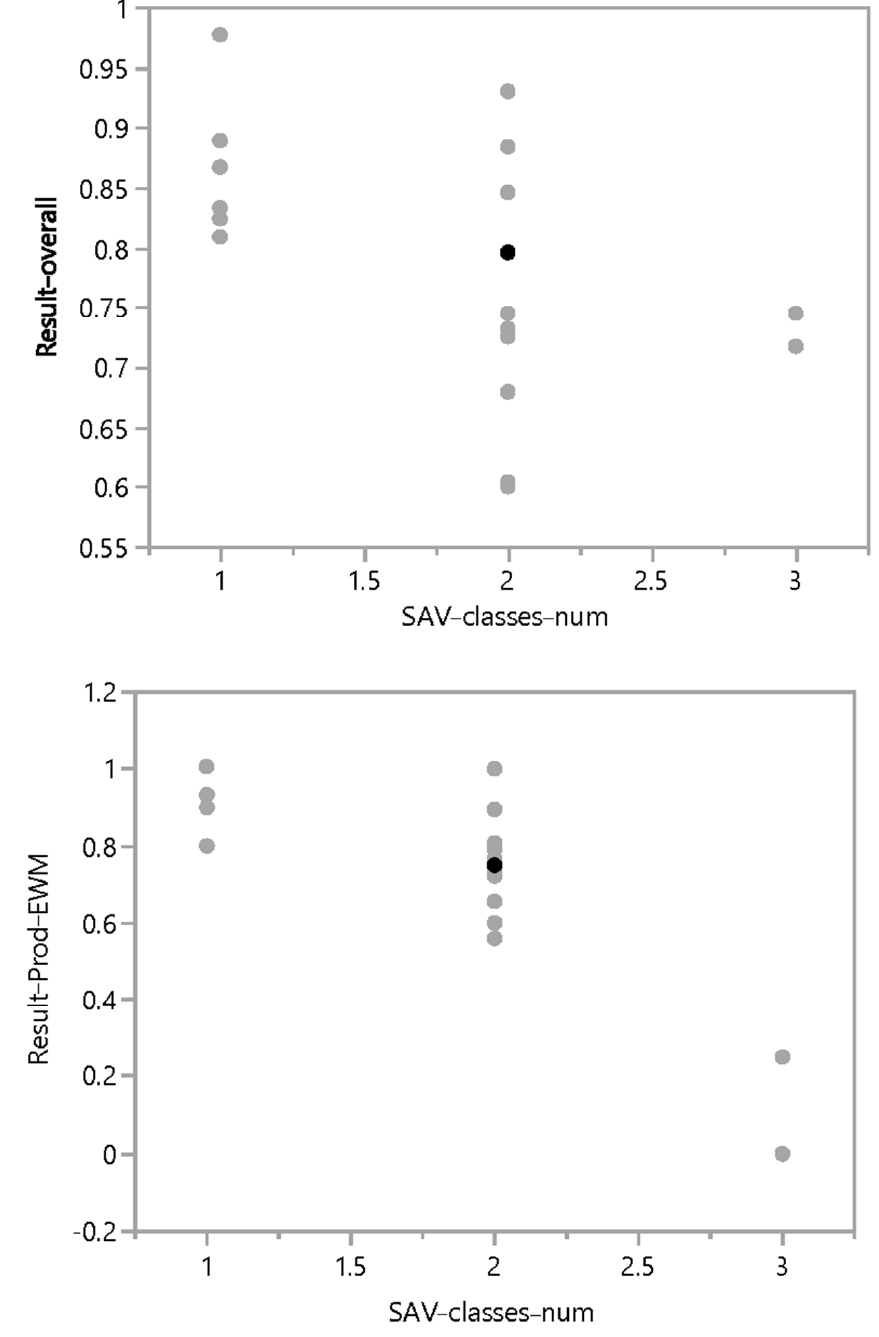
Figure 10. Overall accuracy vs. number of SAV classes showing the data used for the number of species (SAV-classes-num) vs. overall accuracy results (Resultoverall) at top, and number of species vs. producer’s accuracy (Result-Prod-EWM) at bottom.